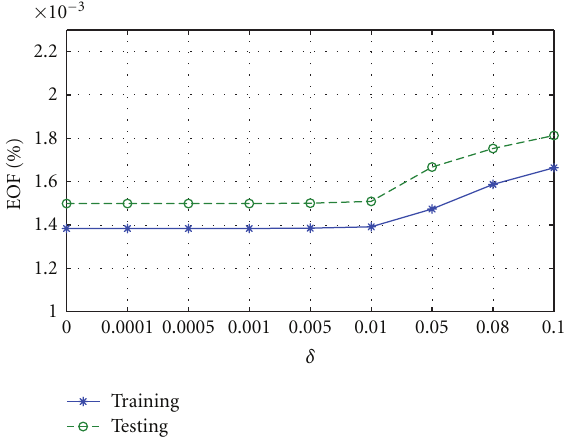
Figure 14: EOF of gallbladder reconstruction increases as δ gets larger for both training and testing